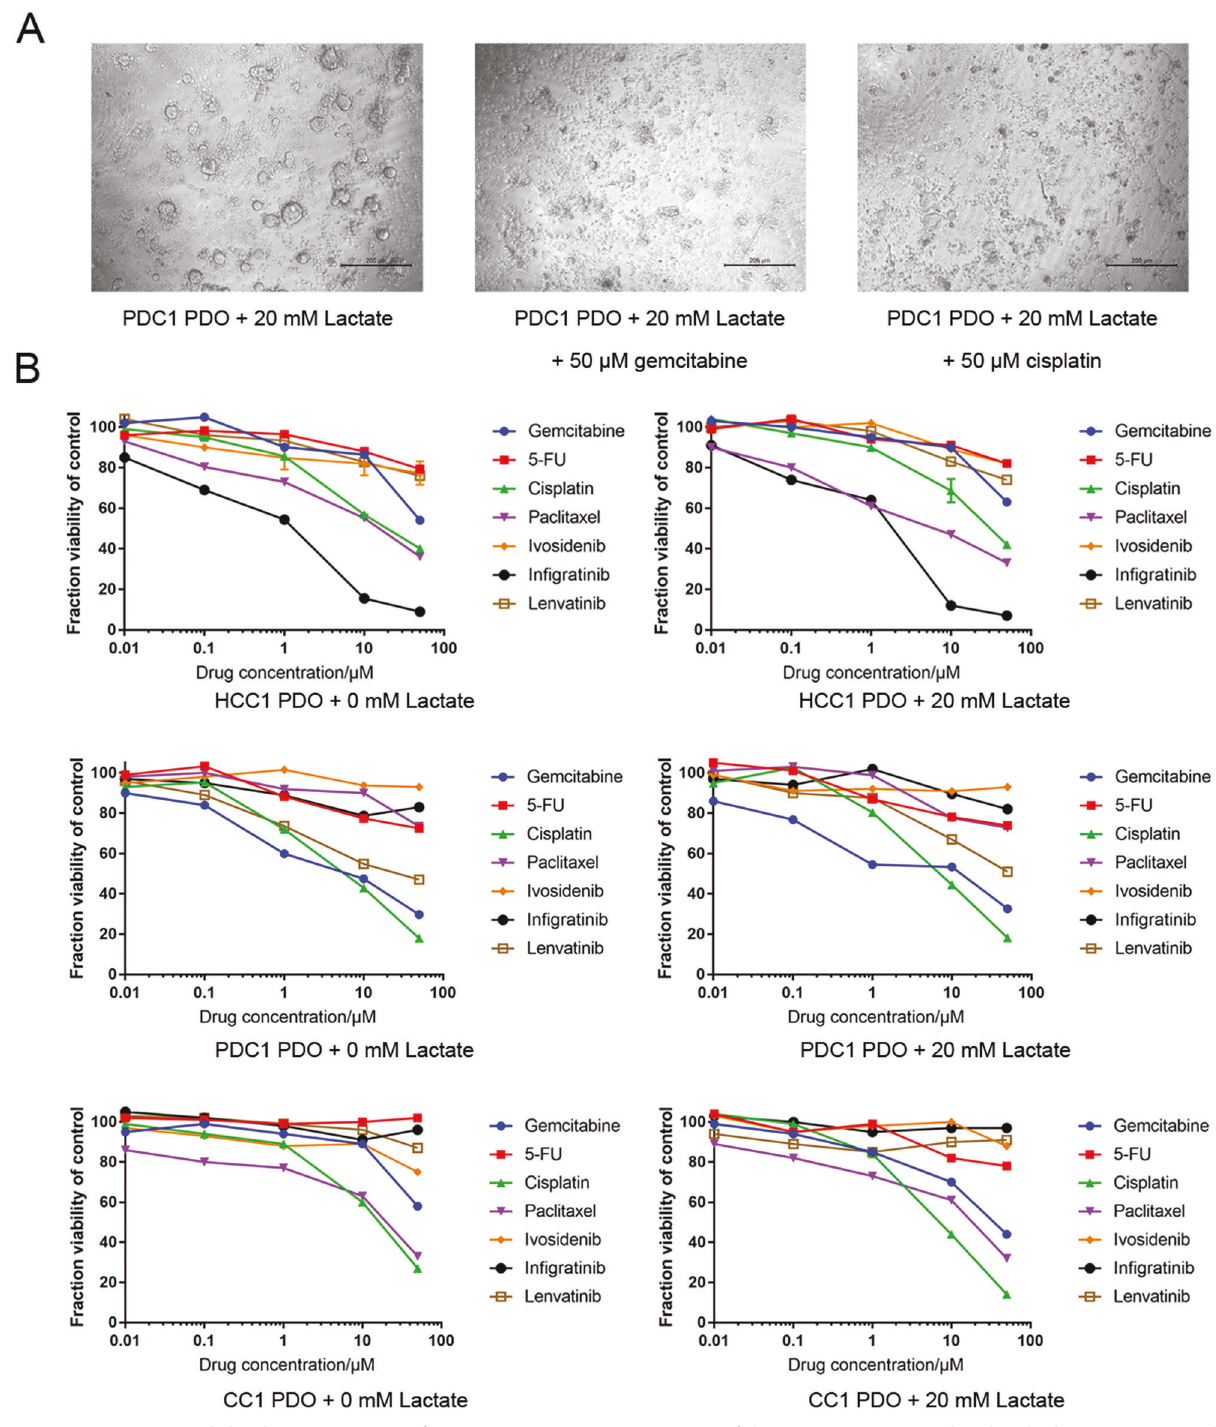
Fig. 5 Lactate maintained the drug sensitivity of PDOs. A Representative images of the PDC1 PDOs treated with vehicle, 50 μ M gemcitabine, and 50 μ M cisplatin. B Dose – response curves of HCC1, PDC1, and CC1 PDOs without or with 20 mM lactate treatment to 7 drugs (indicated in the chemotherapeutic drugs are used as the fi rst-line treatment corresponding PDOs from liver tumors [12]. Both groups proposed against PDC and CC, and lenvatinib is the fi rst-line targeted drug that >80% genetic similarity between PDOs and corresponding for HCC. Ivosidenib is an inhibitor of isocitrate dehydrogenase 1 parent tissues indicated appropriate PDO culture, and also (IDH1) and signi fi cantly improved the progression-free survival of con fi rmed the effects of lactate. IDH1-mutant CC patients compared to that of the placebo arm We tested the impact of lactate on the response to gemcitabine, [37]. In fi gratinib is an inhibitor of fi broblast growth factor receptor 5- fl uorouracil, cisplatin, paclitaxel, and three targeted drugs 2 (FGFR2) and has shown promising therapeutic effects in including ivosidenib, in fi gratinib, and Lenvatinib. The four